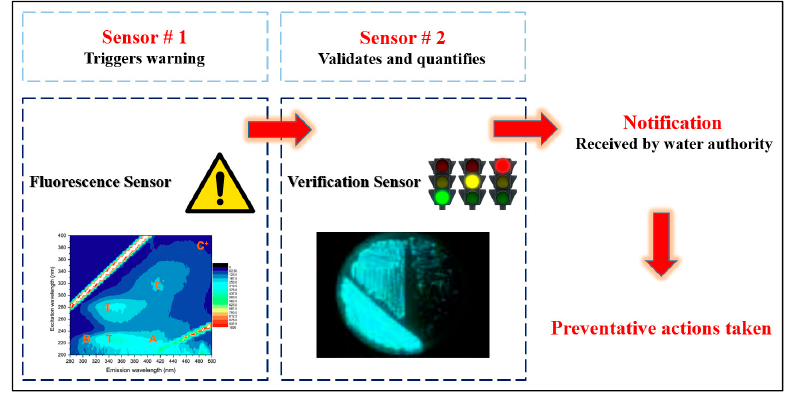
Figure 3. Functioning principles of a hybrid sensor for faecal indicator bacteria.